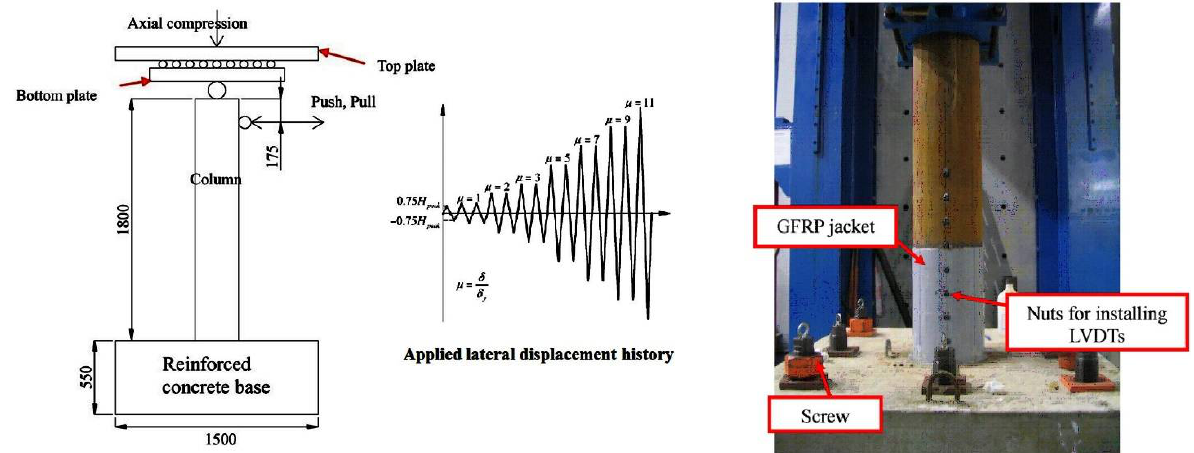
Figure 1. Test setup (dimensions are in mm). Reprinted from Yu et al. [32].